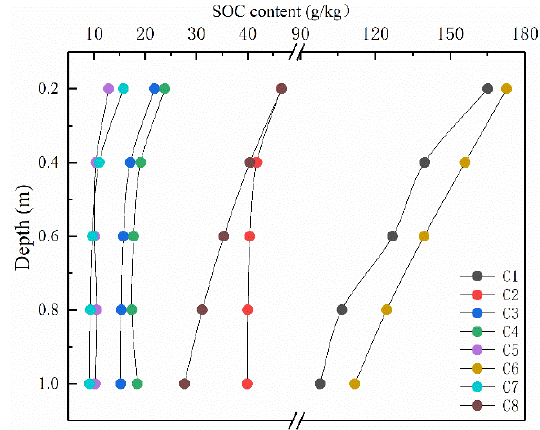
Figure 5. Changes in SOC content with soil depth for each geographic region.